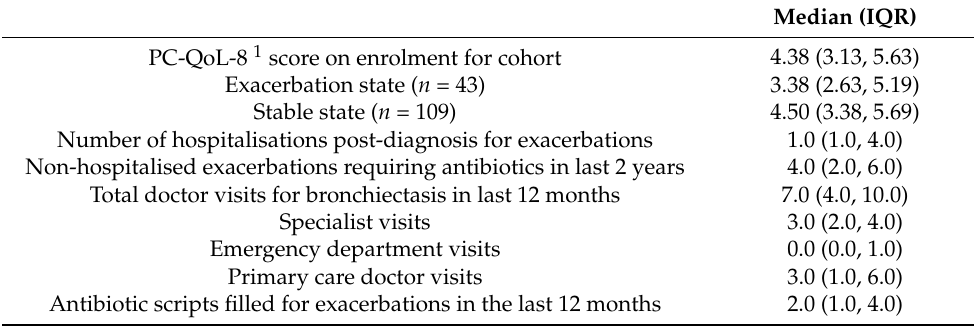
Table 2. Burden of illness ( n = 152).